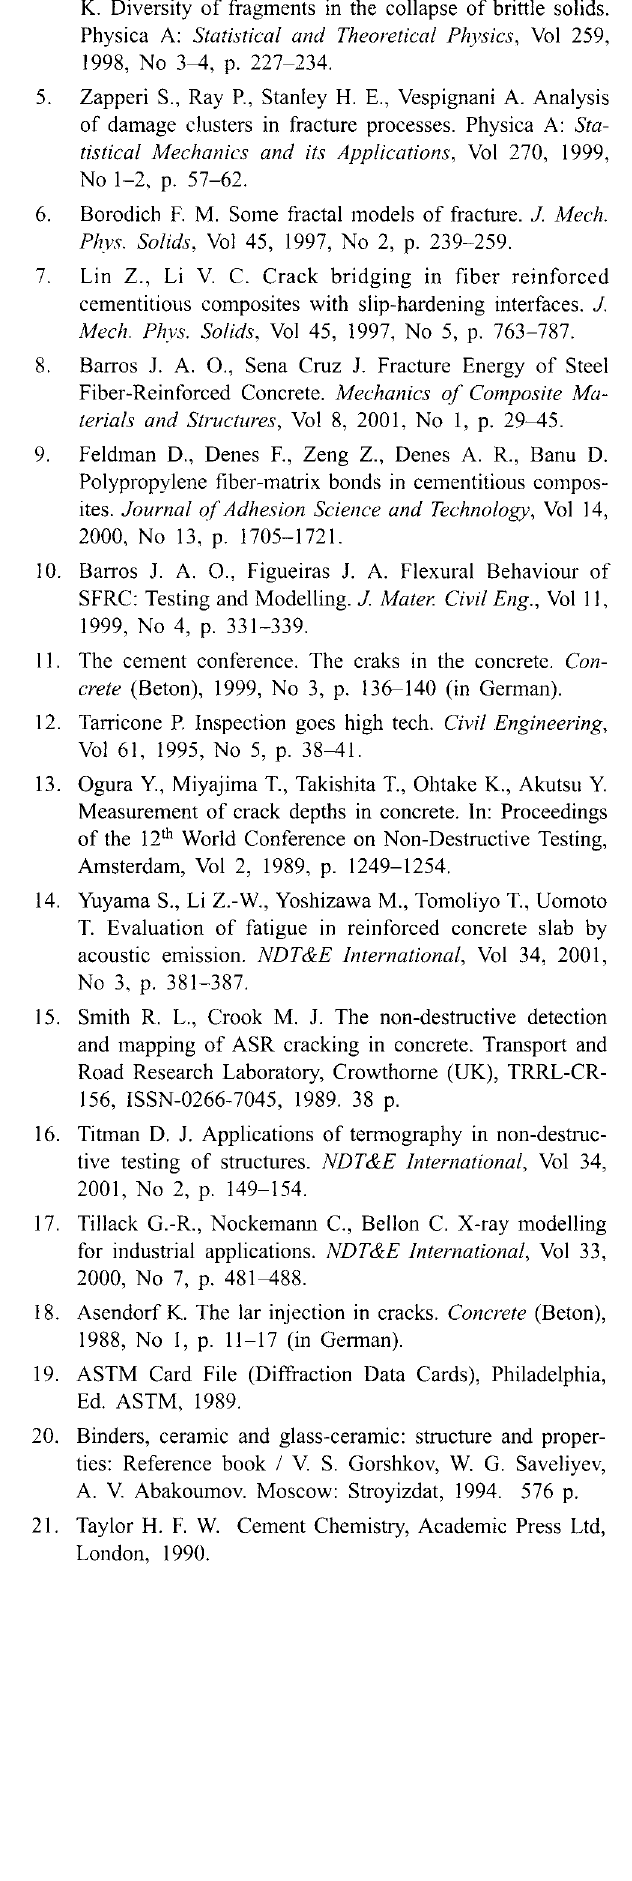
Fig 7. Initiating cut inside the concrete, the marker shows the cut depth